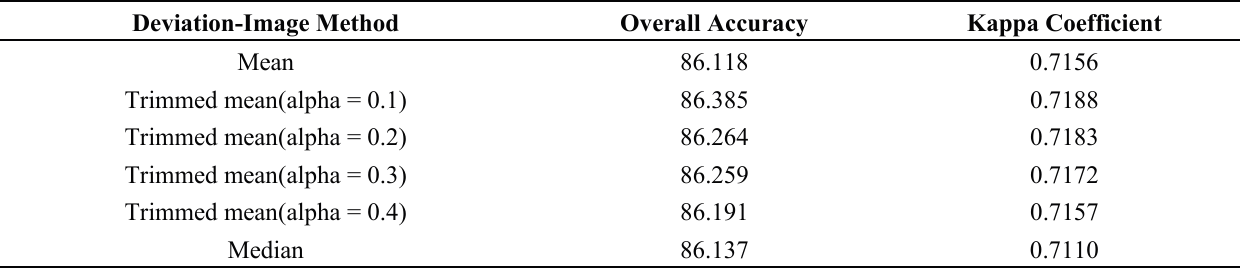
Table 1. Overall Accuracy and Kappa Coefficient for the optimum threshold values between deviation image (mean, trimmed mean and median) and the reference data (Landsat-TM